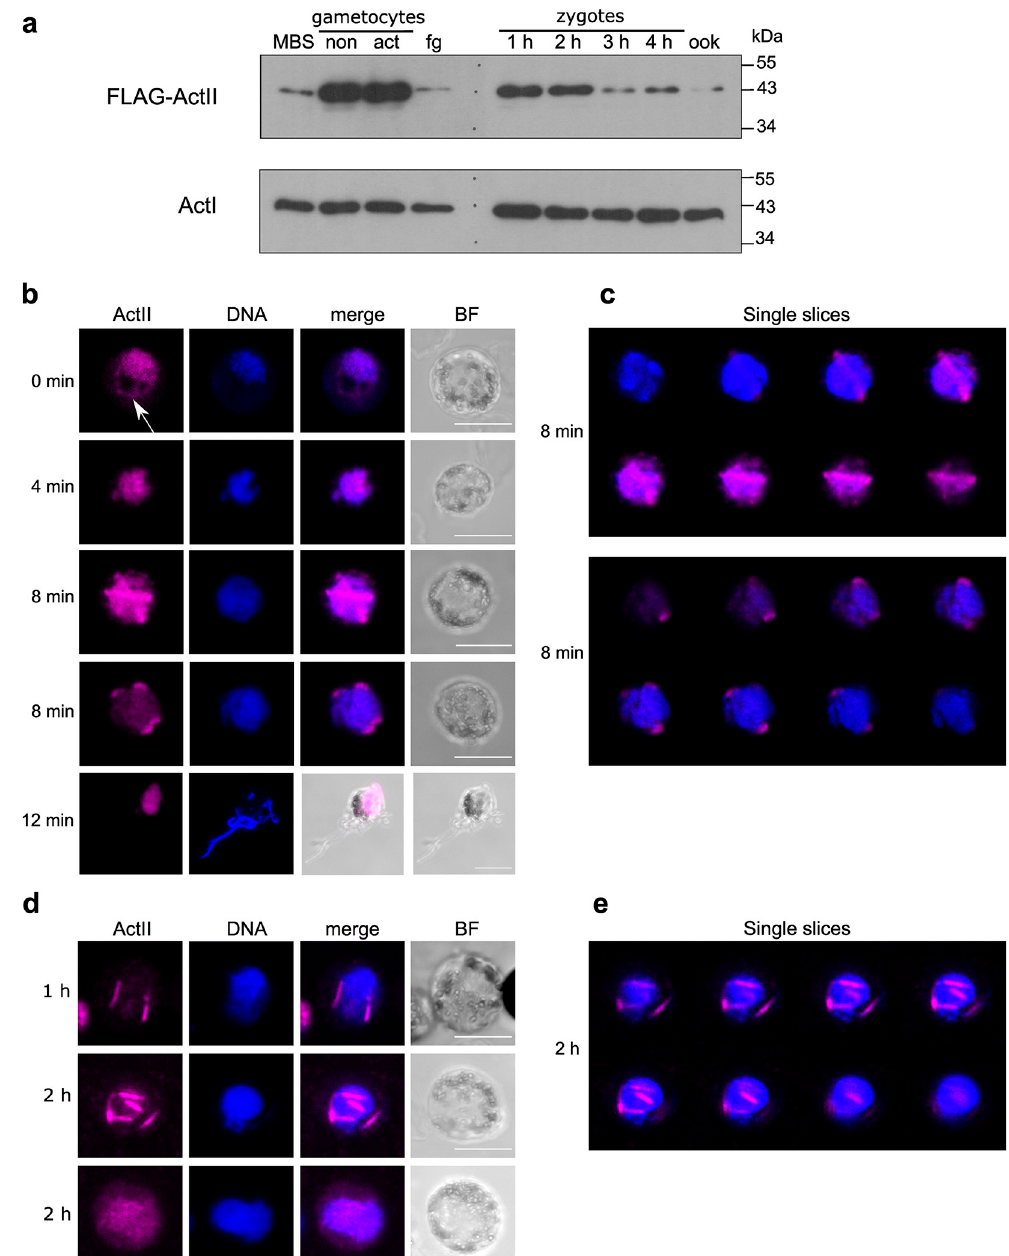
Fig 1. Expression of actin II in mosquito stages. (a) Western blot of crude extracts of gametocytes, zygotes, and ookinetes. The lanes from left to right contain: mixed blood stages containing asexual parasites and gametocytes (MBS); non-activated (non) gametocytes; activated (act) gametocytes; female gametes (fg); zygotes 1, 2, 3, and 4 h post activation; ookinetes (ook). mw denotes the size (in kDa) of the molecular weight markers. Actin II was visualized with an anti-FLAG antibody. For loading controls, a duplicate blot was probed with a monoclonal antibody specifically recognizing actin I [22]. The exposure time was different for the two blots, as actin I is expressed at much higher levels than actin II. (b, c) Localization of actin II in male gametocytes. Samples of infected blood were fixed at different times (indicated on the left) after activation by dilution in ookinete medium. Cells were labeled with a commercial anti-FLAG antibody, followed by a conjugated secondary antibody (Alexa-647; pink), and DNA was stained with Hoechst 33342 (blue). Controls with only the secondary antibody were included in the experiment; these had no signal (not shown). Imaging was done on a confocal microscope, and the images are projections of z-stacks. Scalebars: 5 μ m. (c) Montage of single slices of the z-stacks of the two 8 min samples shown in (b). (d, e) Localization of actin II in zygotes. Zygotes were purified at 1 and 2 h after activation (indicated on the left) by magnetic beads carrying an antibody directed against the P28 surface protein, which is expressed in activated female